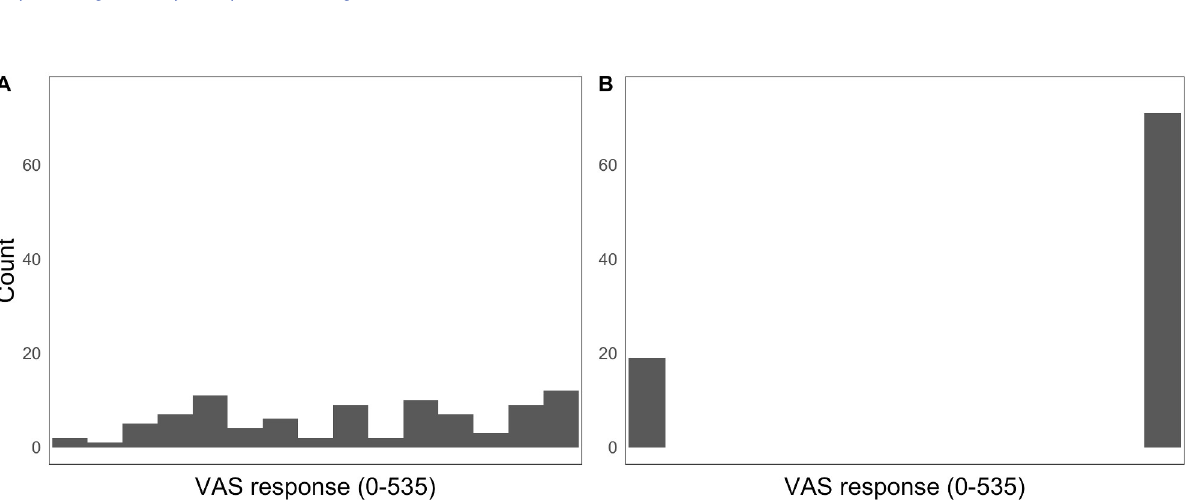
PLOS ONE | https://doi.org/10.1371/journal.pone.0207160 November12,